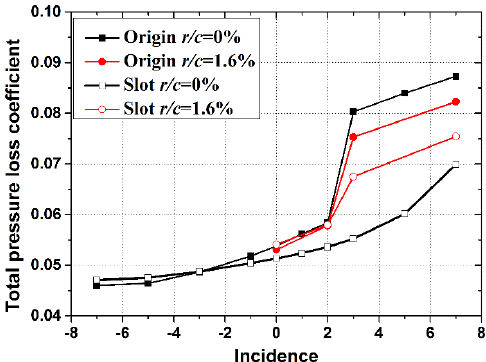
Figure 12. Influence of fillet radius for different incidence angles on the total pressure loss coefficient without the slot configuration.